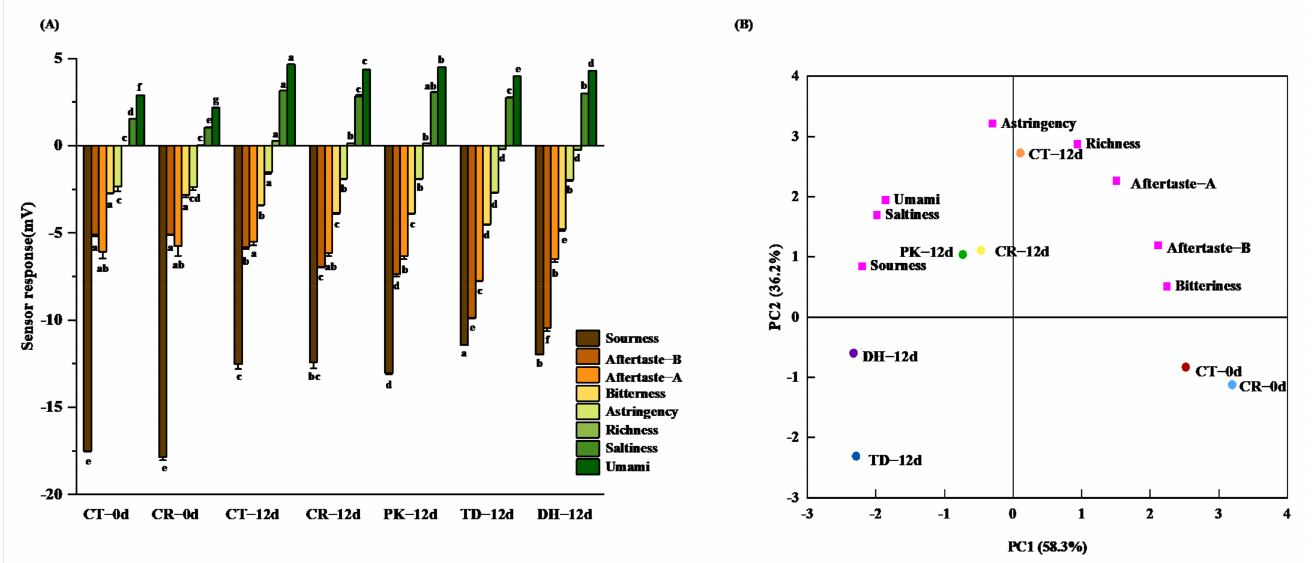
Figure 2. Column chart ( A ) and principal component analysis ( B ) of electronic tongue data for the control and reduced-salt dry sausages with and without yeast inoculation on days 0 and 12. CT: 2.50% NaCl; CR: 1.75% NaCl; PK: 1.75% NaCl + P. kudriavzevii ; TD: 1.75% NaCl + T. delbrueckii ; DH: 1.75% NaCl + D. hansenii . Different lowercase letters (a–g) for the same taste attribute indicate significant differences among the different treatments ( p <